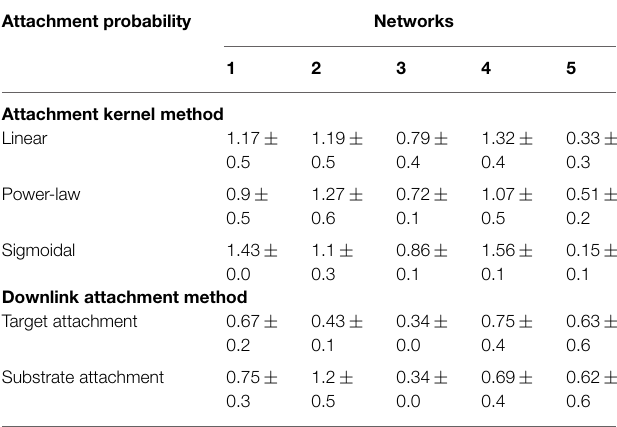
TABLE 5 | Statistics or the difference between fitted power-law exponent for candidate and target networks’ distributions of genes participating in downlinks